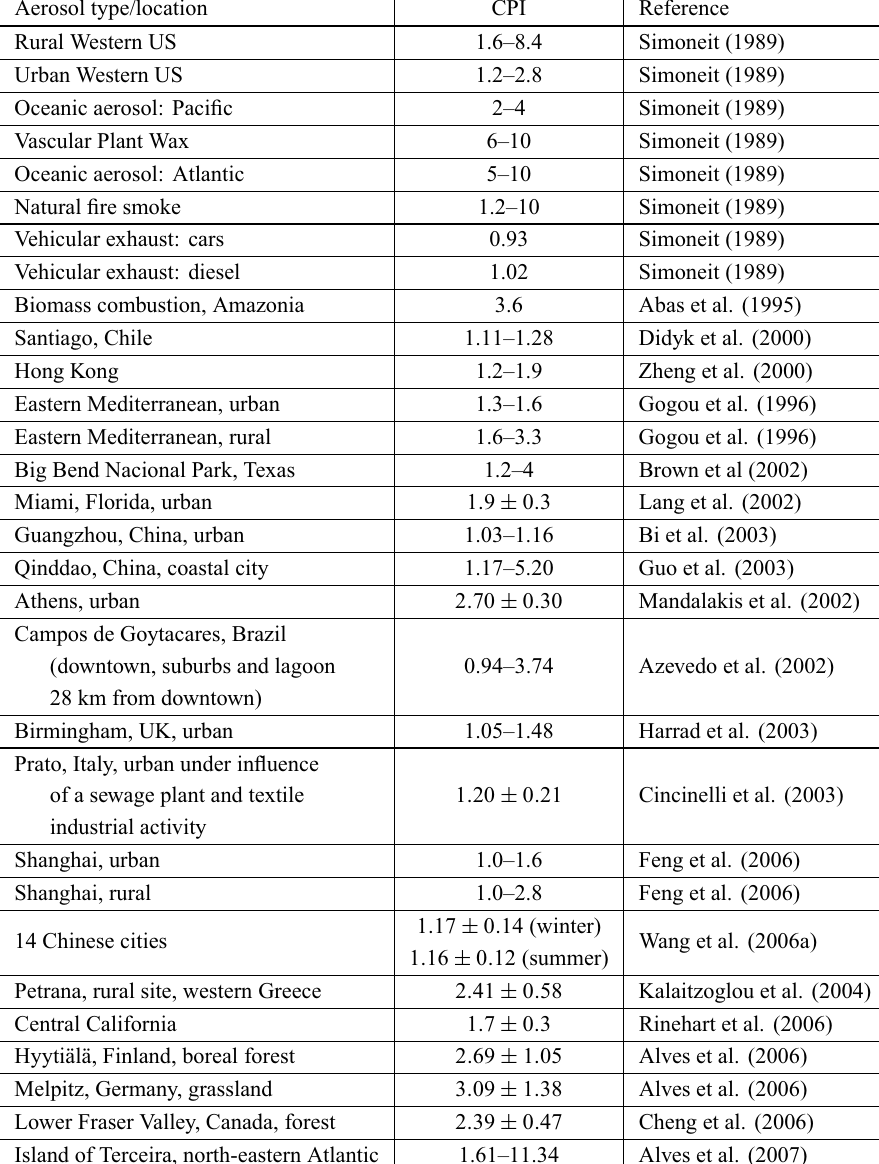
Carbon Preference Index of n -alkanes for various aerosol